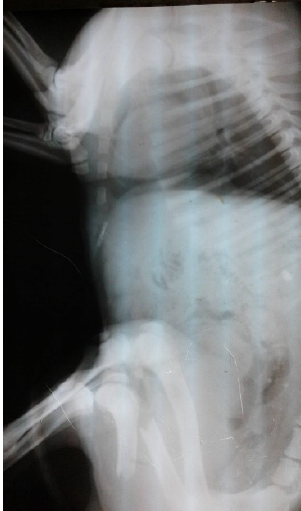
Fig. 10. Radiography in young dog showed 3 long bones